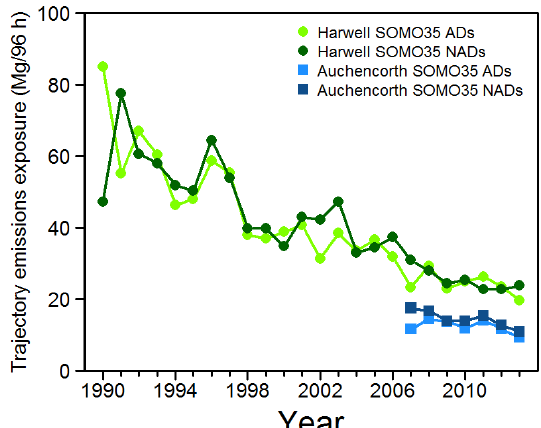
Figure 6. Amplitude of the diurnal O 3 , NO 2 and NO cycles at Har- well and Auchencorth during SOMO35 accumulation days (ADs). Figure 7. Estimate of the hourly European NO x emissions emitted from the EMEP 0.5 ◦ grids over which 96h back trajectories passed prior to arrival at Harwell and Auchencorth for SOMO35 accumu- lation days (ADs) and non-accumulation days